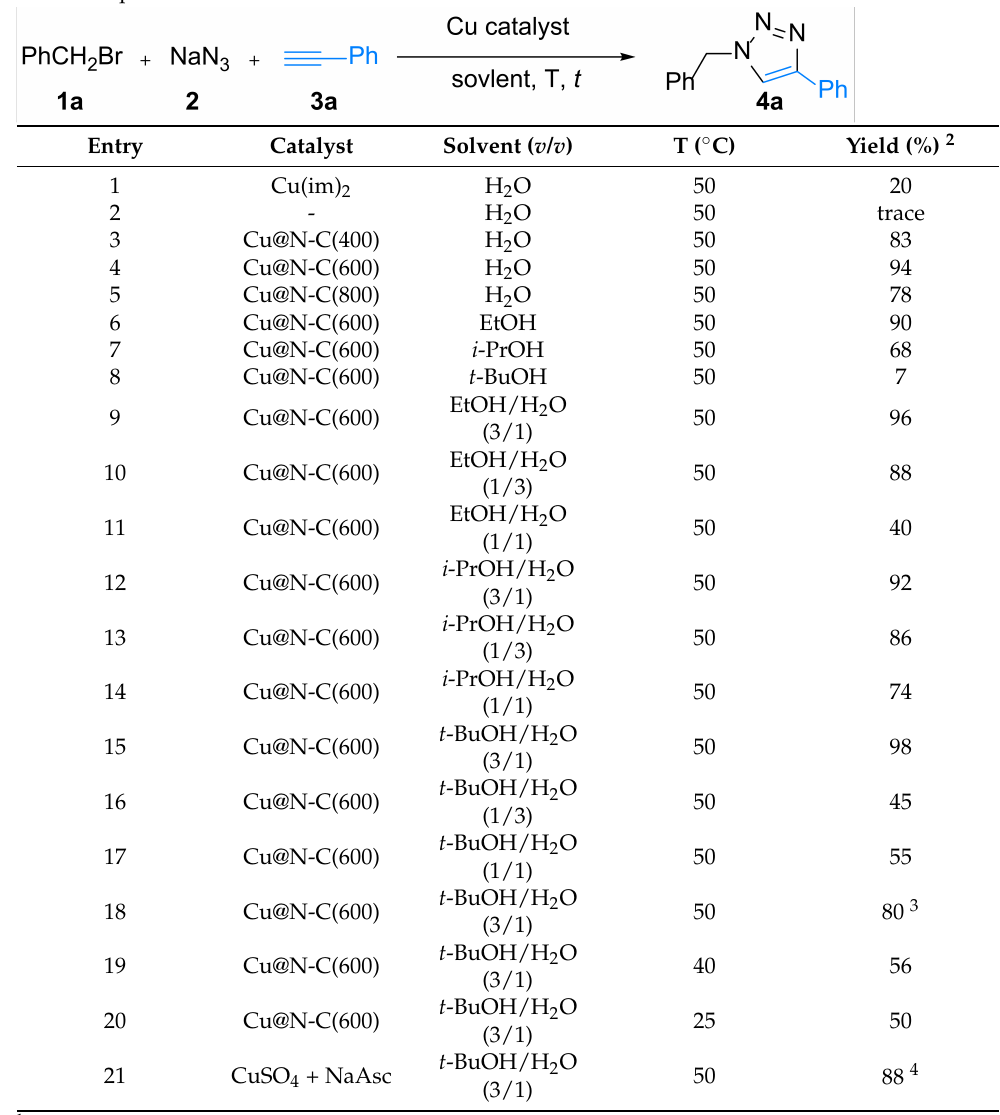
Table 2. Optimization of the reaction conditions 1